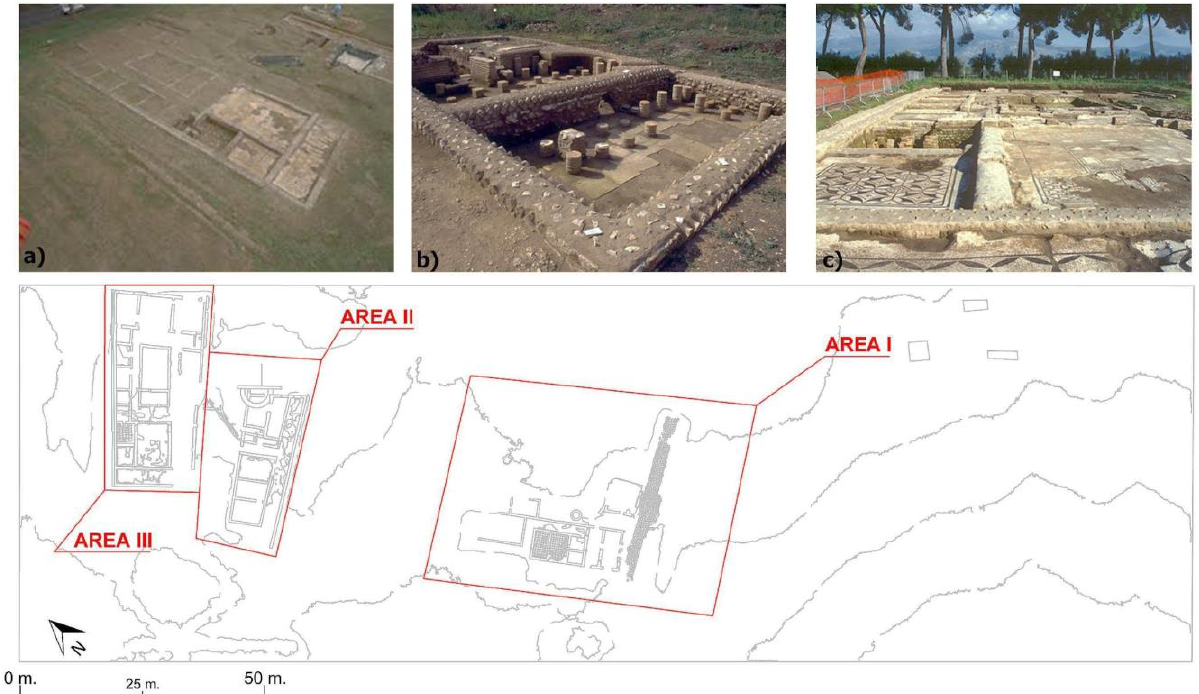
Figure 3. Visible buildings before ground truth verification: ( a ) UAV image of Area III; ( b ) bath complex; ( c ) structures in Area III paved in mosaics.